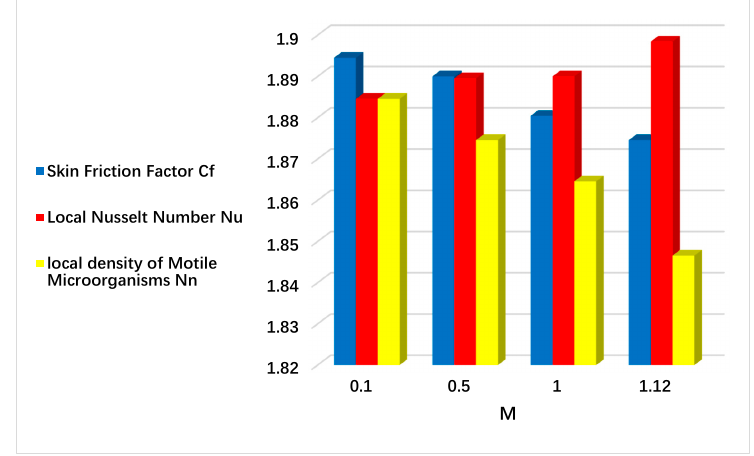
Figure 21. Effect of γ on C f , Nu, and Nn .